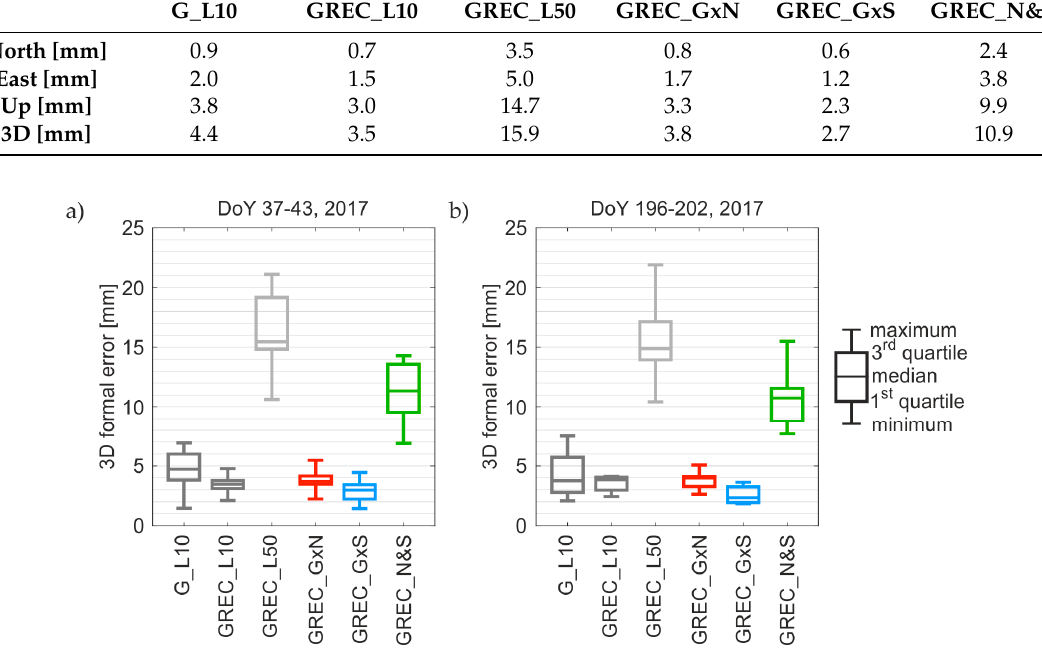
Figure 6. 3D formal errors of coordinates obtained in static PPP using different weighting schemes.